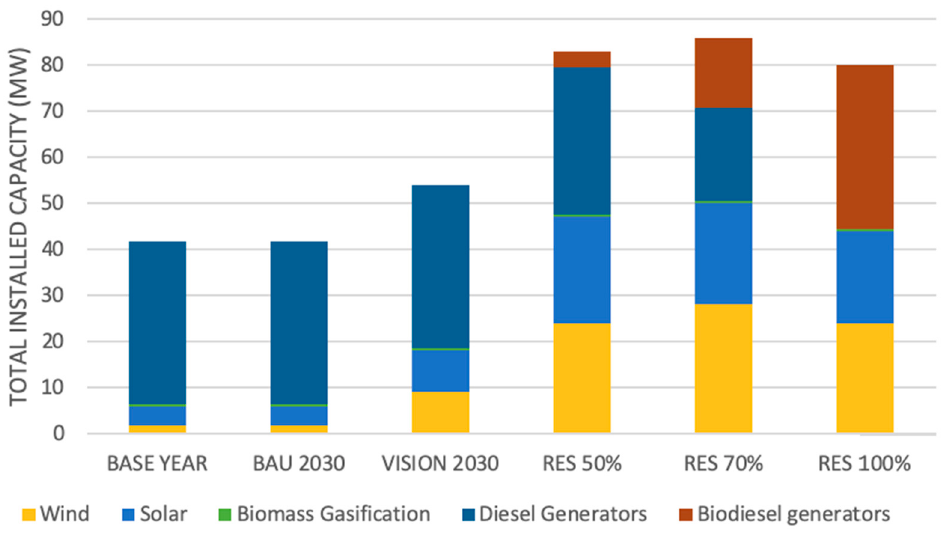
Figure 8. Total installed capacity (MW) in 2019 and in the future scenarios by 2030. RES penetration shares as percentages of primary energy supply and electricity pro- duction are shown in Figure 9. In BAU 2030, RES account for 15% of the total installed capacity and 8% of the total annual electricity production, in VISION 2030 34% and 25%, in ARES 62% and 50%, in HiRES 76% and 70%, and in FullRES 100% and 100%, respec- tively. It has to be noted, however, that FullRES is producing more than 100% of the share in the electricity production due to excess generation that can be seen also in Figure 10.